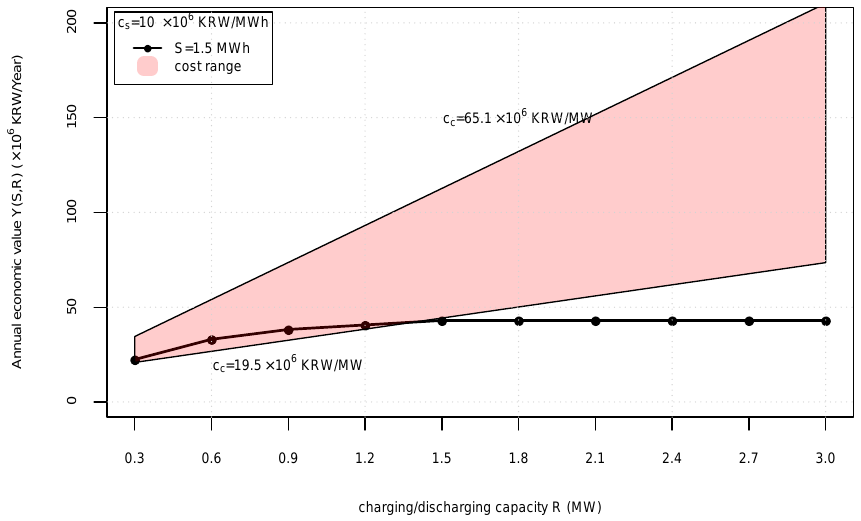
Figure 9. Annual economic values Y ( S , R ) for different values of R and the range of unit cost per year c r when S = 1.5 MWh and c s = 10 × 10 6 KRW/MWh/year.